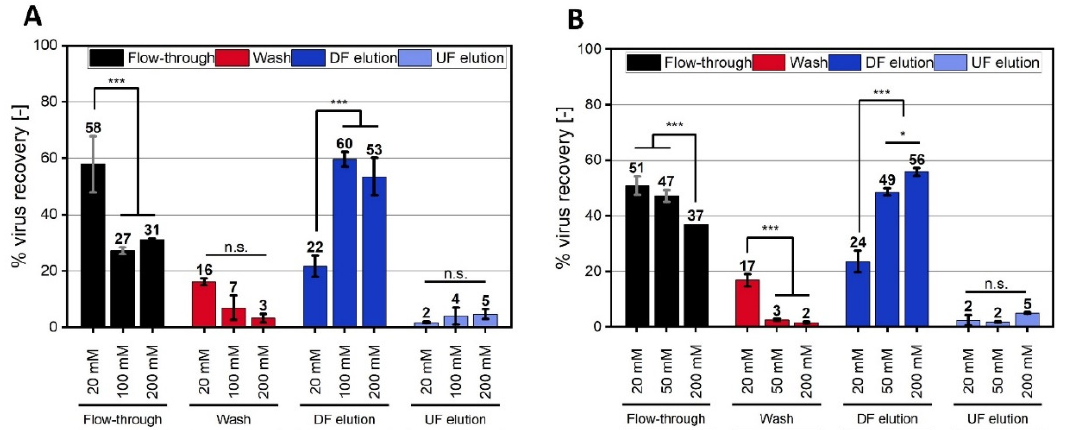
Figure 6. Steric exclusion chromatography (SXC) of the Orf virus (ORFV) with NaCl and NaNO 3 at concentrations up to 200 mM. The SXC of the ORFV was performed with 8% PEG 6000 (polyethylene glycol, 6000 Da) in the loading buffer, 0% PEG, and 0.4 M NaCl in the elution buffer. 20 mM TRIS buffer and pH 7.4 were used for all experiments. The load and wash were supplemented with 20‒200 mM of NaNO 3 ( A ) or NaCl ( B ). The load was stopped when the pressure limit of 0.4 MPa was reached, or when 40 mL PEG/ORFV suspension were applied. The runs were fractionated into flow-through (load), wash, and the two elutions, up-flow, UF, (in the direction of loading), and down-flow, DF, (counter-flow). Each fraction was analyzed for its relative ORFV recovery. The statistical analysis of the recoveries was performed via ANOVA with a Tukey test ( α = 0.001) for n = 3. Asterisks (***) indicate significant differences within the respective group.